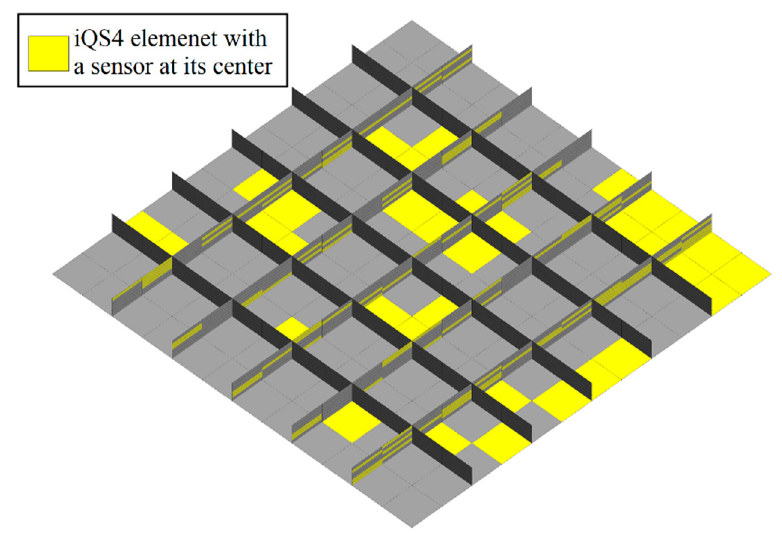
Figure 25. Optimized sensor distribution for the stiffened plate obtained with the iFEM-GA